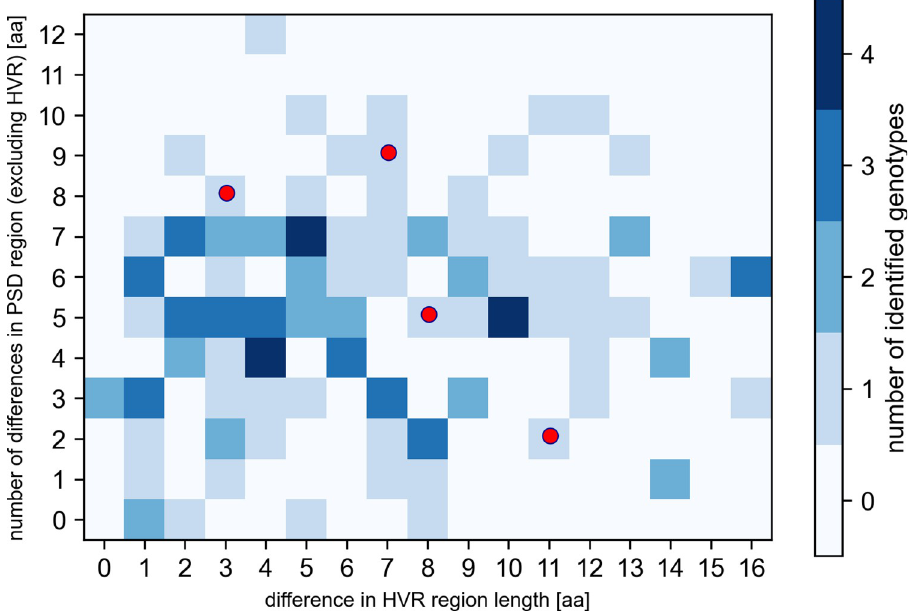
carried the mA/p66 genotype. The mB and p66 alleles differed from each other by a trinucleo- tide indel (AAT) encoding asparagine residue localised in the hypervariable portion of the pro- tein. The difference between p66 and the other maternal allele (mA) was more profound (a 3 a-a difference in the HVR length, 5 other a-a mismatches in HVR, and 3 a-a differences in the P-domain) (Fig 5). In order to exclude the possibility that the p66 allele was an artefact that had been accidentally derived from the mB allele as a result of a polymerase error during the amplification stage of genotyping, the csd alleles of several specimens assigned to the p66